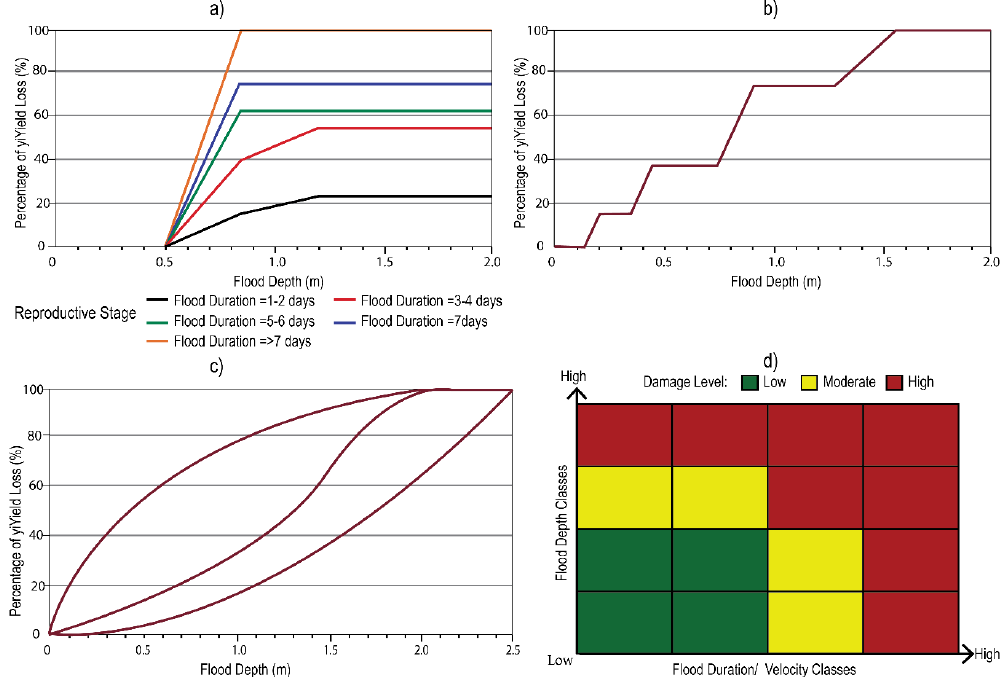
Figure 3. Schematic stage–damage function for flood crop loss assessment. ( a ) Conceptual example